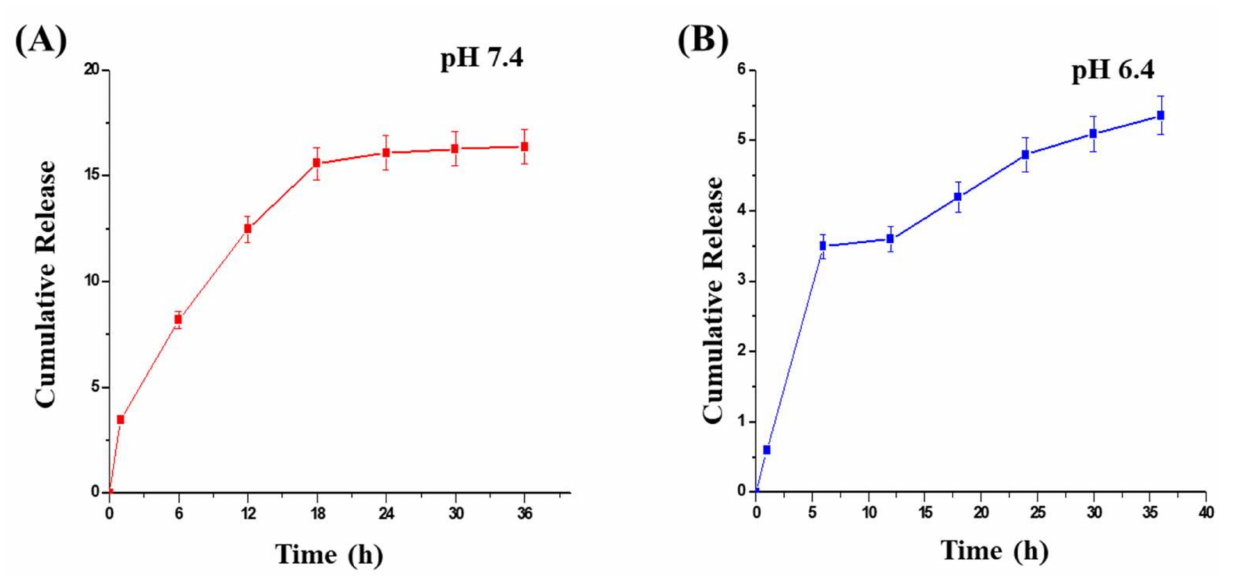
Figure 3. In vitro release profile of F4 formulation at different pH: ( A ) pH 7.4 and ( B ) pH 6.4; all the values are expressed as mean ± SEM ( n =